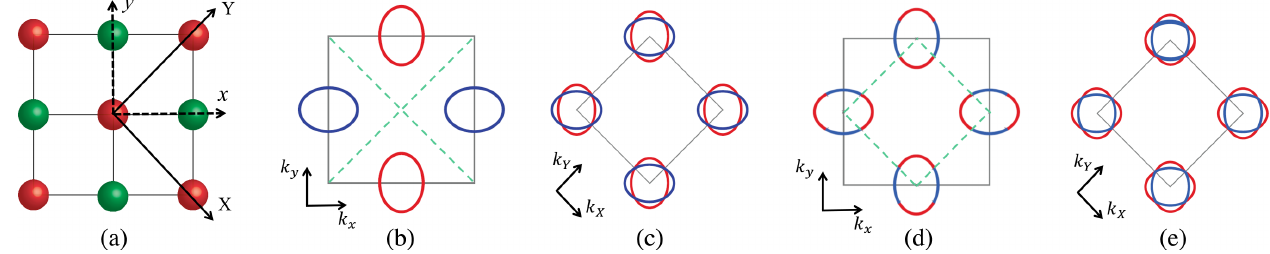
FIG. 11. (a) shows the sublattice structure of monolayer FeSe. (b) – (e) sketch the NN intersublattice pairing states in the absence of spin-orbit coupling, with the pairing sign on the Fermi surfaces indicated by the red and blue colors. (b) and (c) correspond to d -wave pairing and (d) and (e) to s -wave pairing. In the figures, (b) and (d) show the one-Fe-unit-cell case with the pairing nodes marked by the green dashed lines, and (c) and (e) show the two-Fe-unit-cell